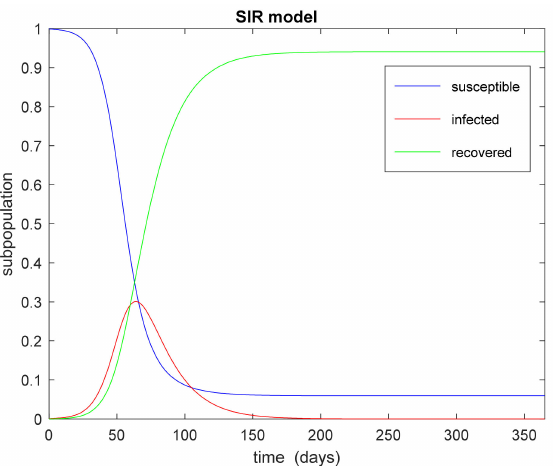
Figure 6. Typical dynamics of the SIR model for the following constant rates: α = 0.18, β = 0.06. Cumulative Viral load (t = 365):